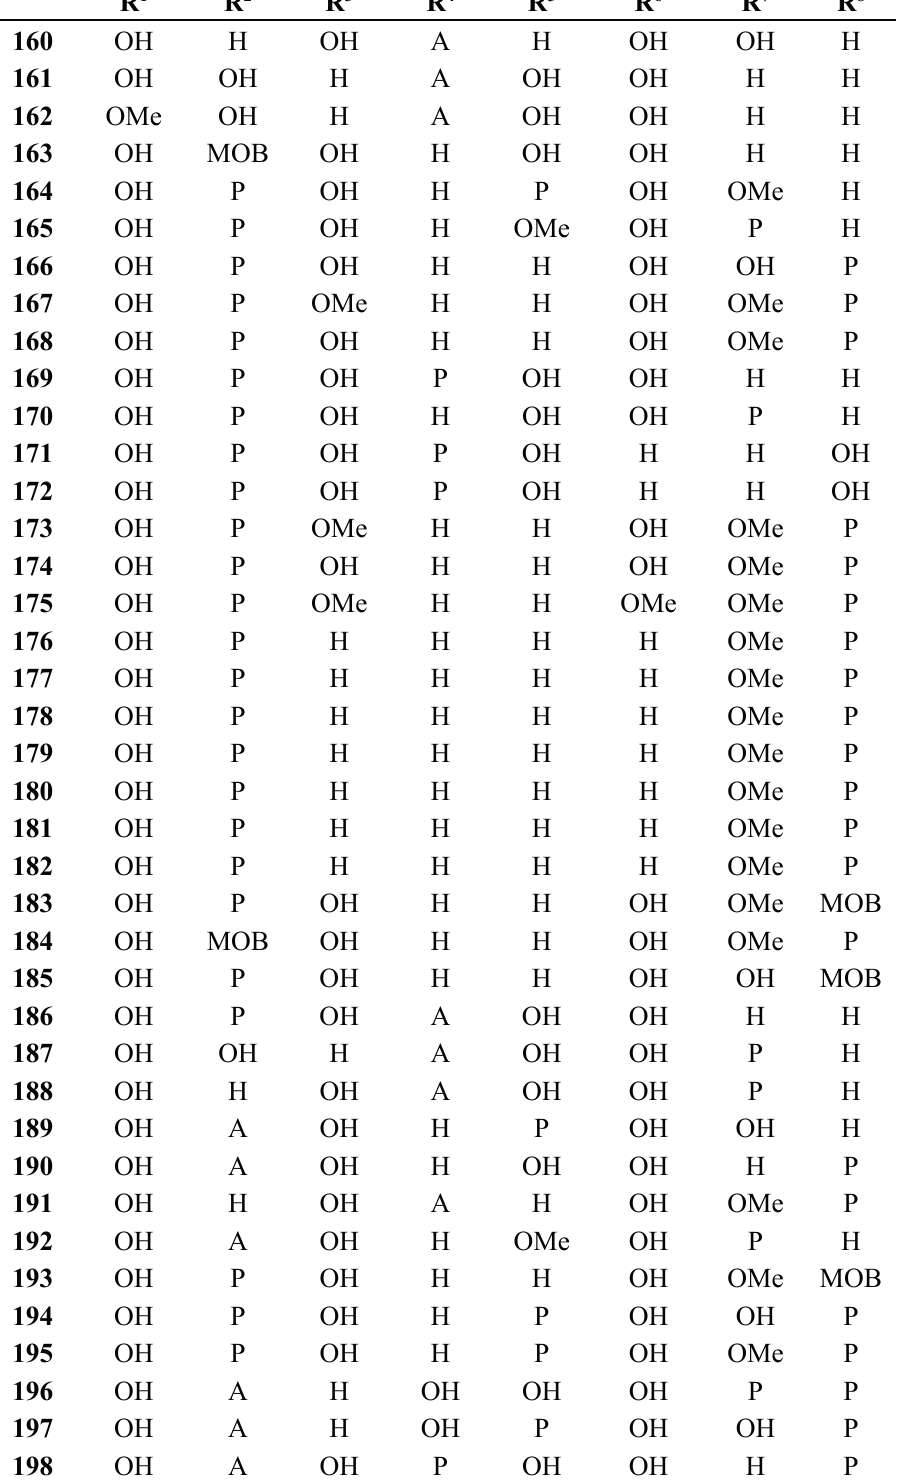
Figure 7. Chemical structures of tested tetraoxygenated and prenylated xanthones. A = 1,1-dimethylallyl; P = Prenyl; MOB =